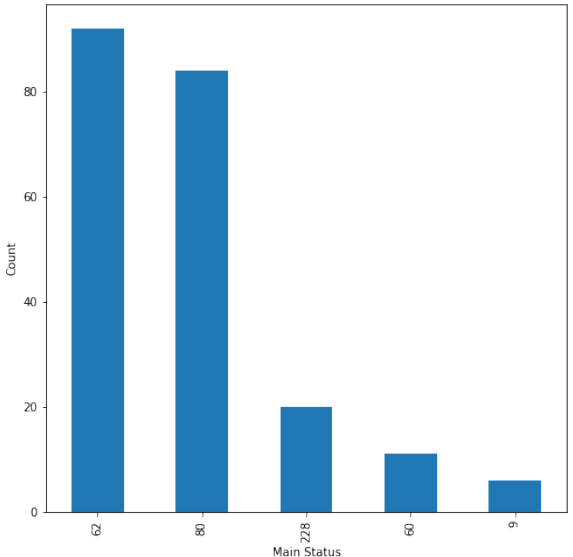
Figure 6. Count of faulty status.